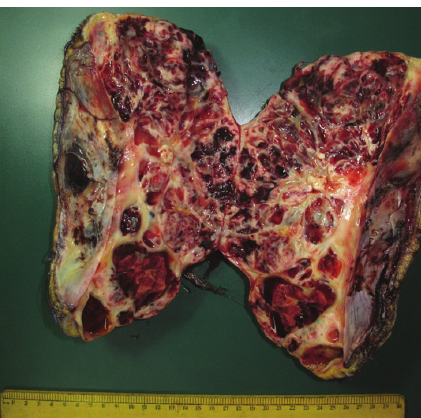
Figure 5: Histopathological specimen of excised tissue revealing the large size of the